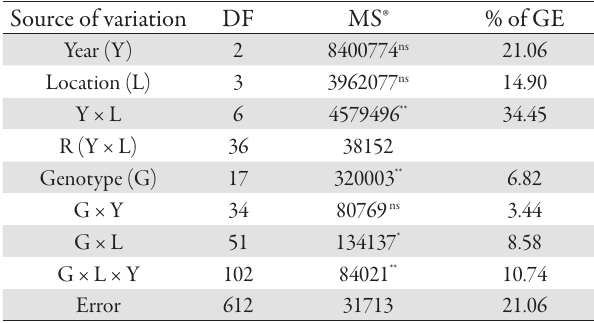
Tab. 3. ANOVA analysis of lentil performance trial yield Source of